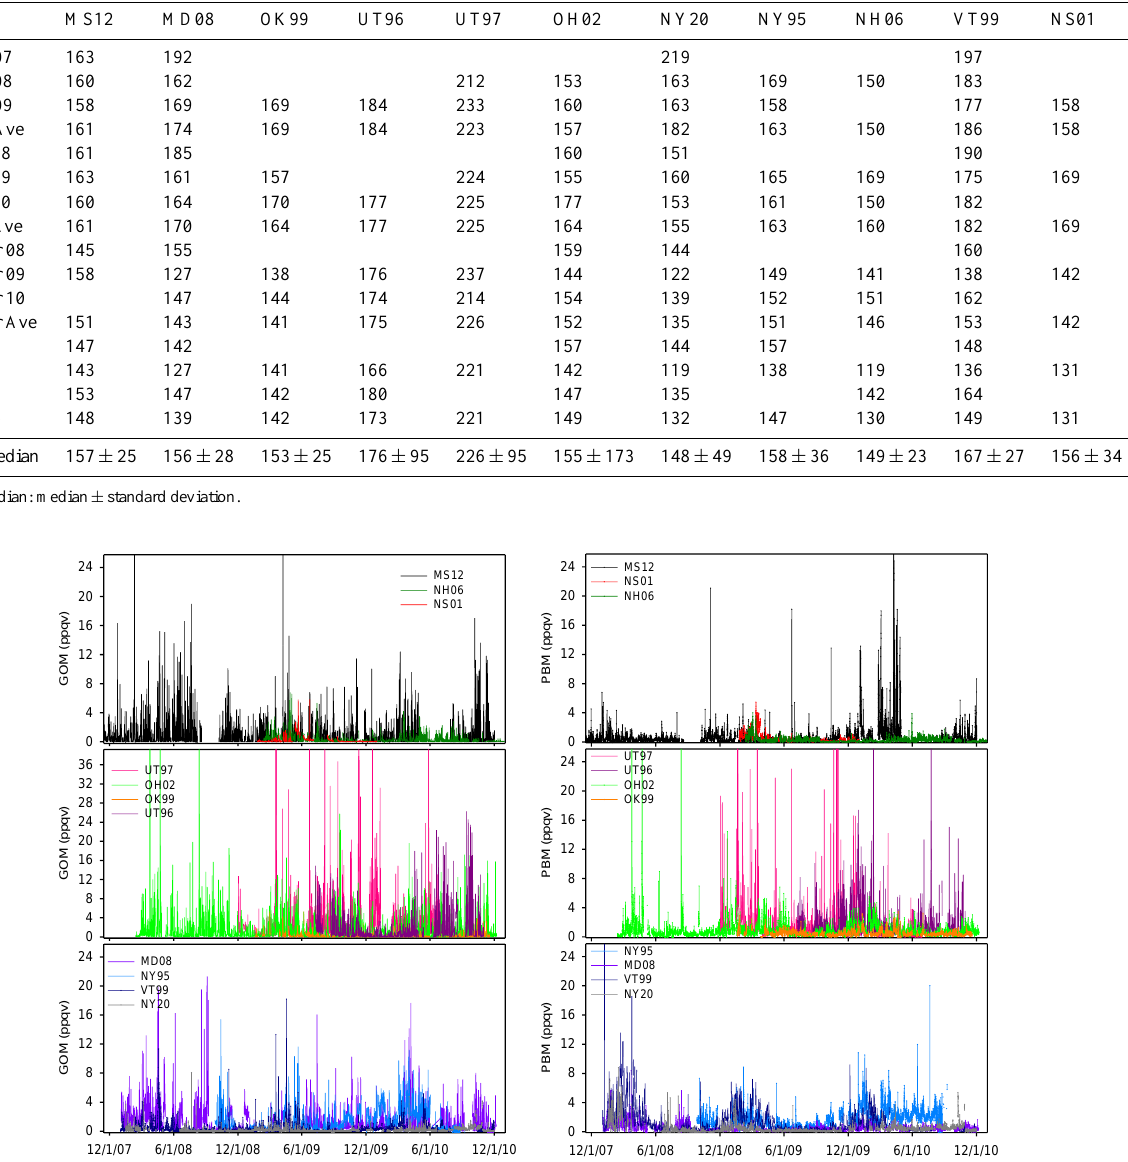
Figure 3. Complete time series of GOM (left panel) and PBM (right panel). Fig. 3. Complete time series of GOM (left panel) and PBM (right